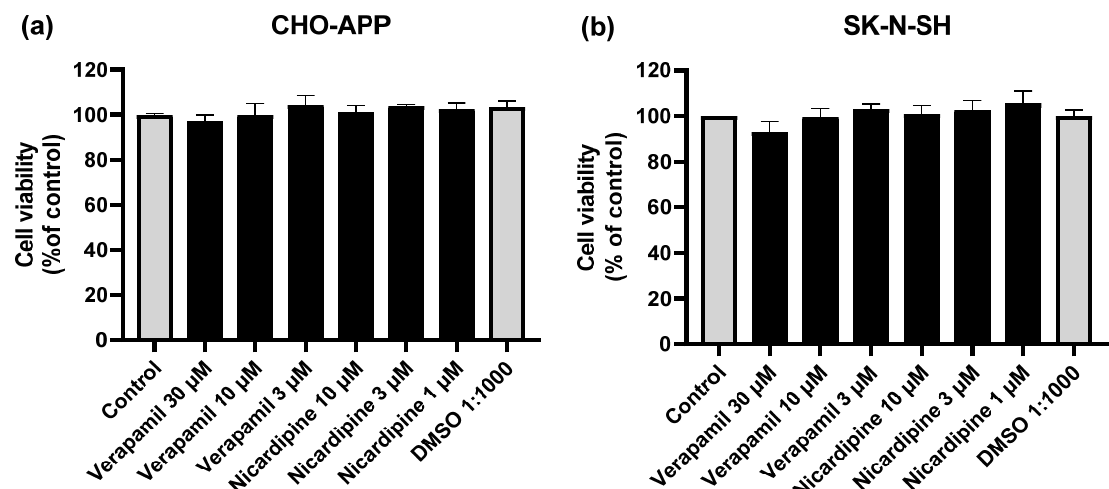
Figure 5. P-gp inhibitors do not affect cell viability. ( a ) CHO-APP and ( b ) SK-N-SH cells were incubated with verapamil or nicardipine at varying concentrations, DMSO, or untreated full culture medium (control) for 24 h to simulate the full experiment duration. The following day, cells were washed and treated with 0.5 mg/mL MTT in serum-free culture medium for two hours at 37 °C. After washing with PBS, cells were lysed with DMSO. Absorbance was measured at 550 nm. Data are presented as mean ± SEM of three independent experiments, each performed with six replicates.